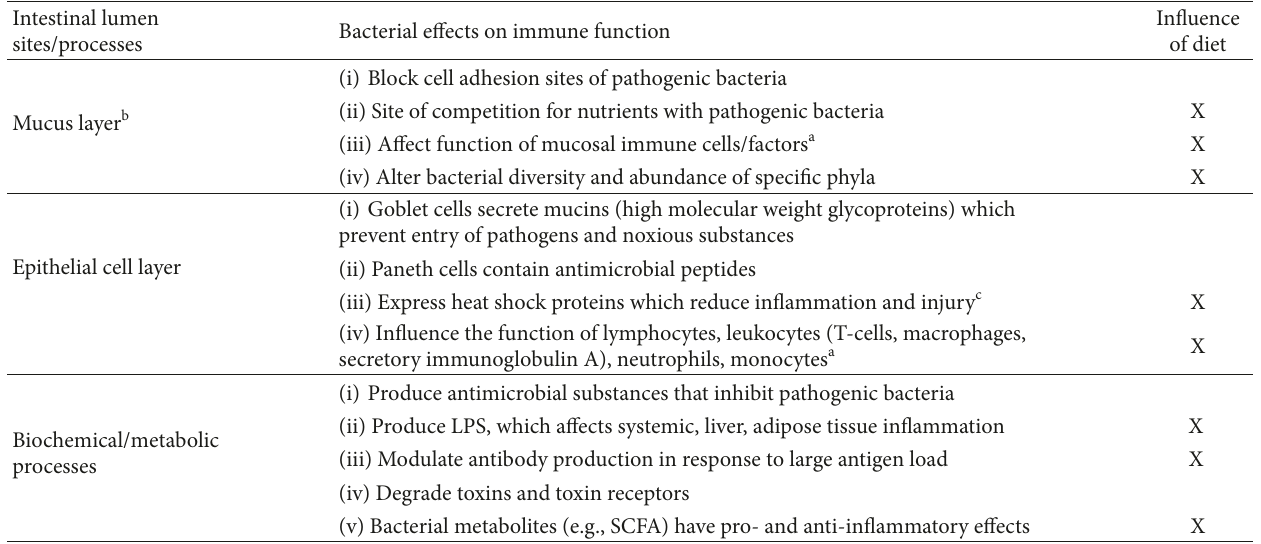
Table 4: Potential effects of the intestinal microbiota (IM) and dietary intake on immune function a